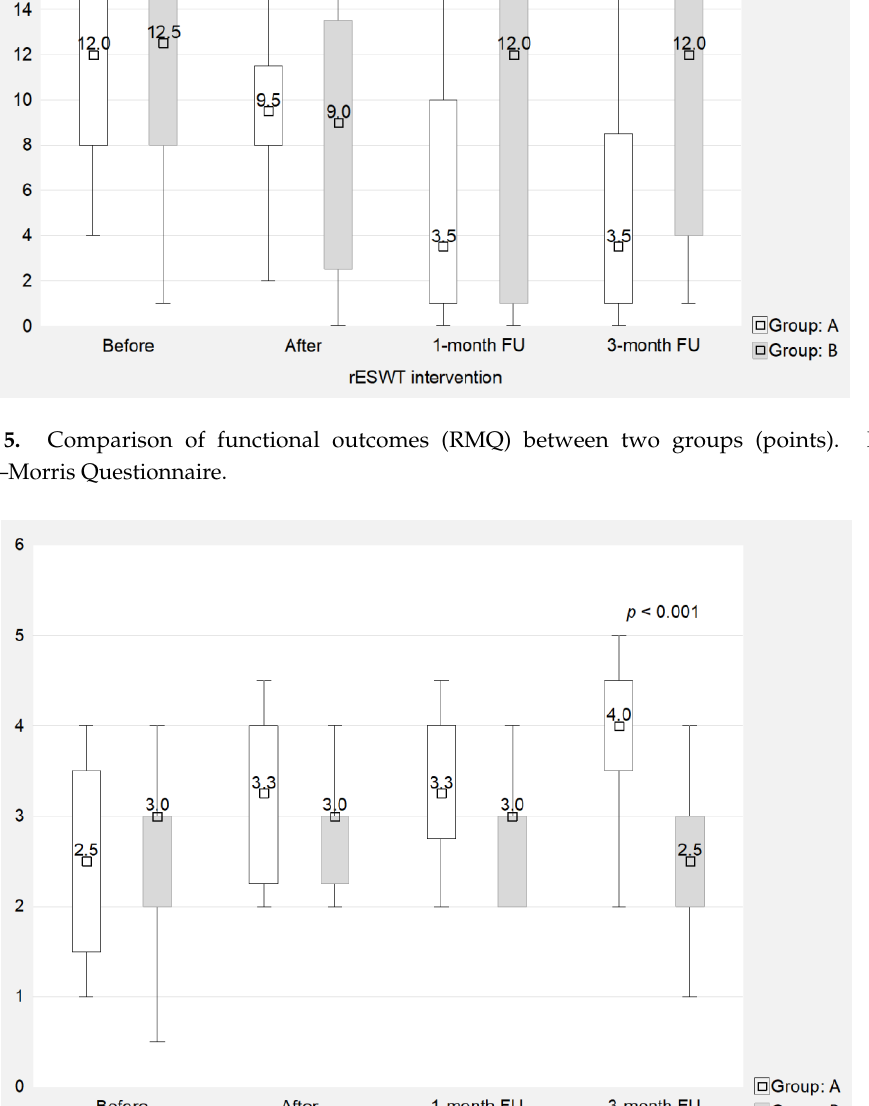
Figure 6. Comparison of the mobility outcomes (OST) between two groups (cm). OST: original Schober Test.